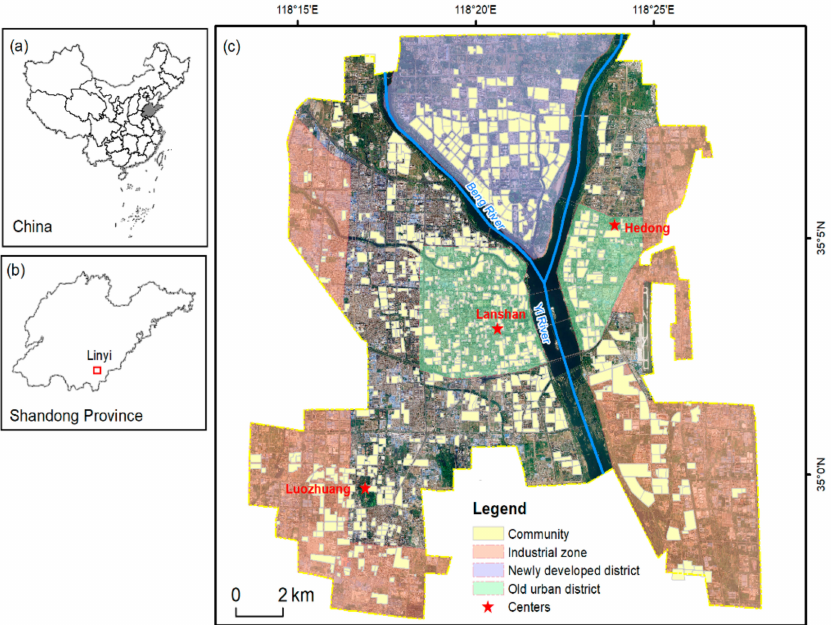
Figure 1. Geographical features of the study area. The inset maps show the geographic location of Linyi ( a ) in China and ( b ) in Shandong Province. ( c ) The main map demonstrates the spatial distribution of communities and urban functional zones. Unlike countries such as the United States and Canada, the community in China often takes the form of a gated residential area with a clear boundary, and consists of several blocks of